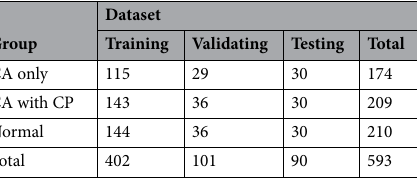
Table 1. Summary of datasets (number of panormaic images). CA cleft alveolus, CP cleft palate.